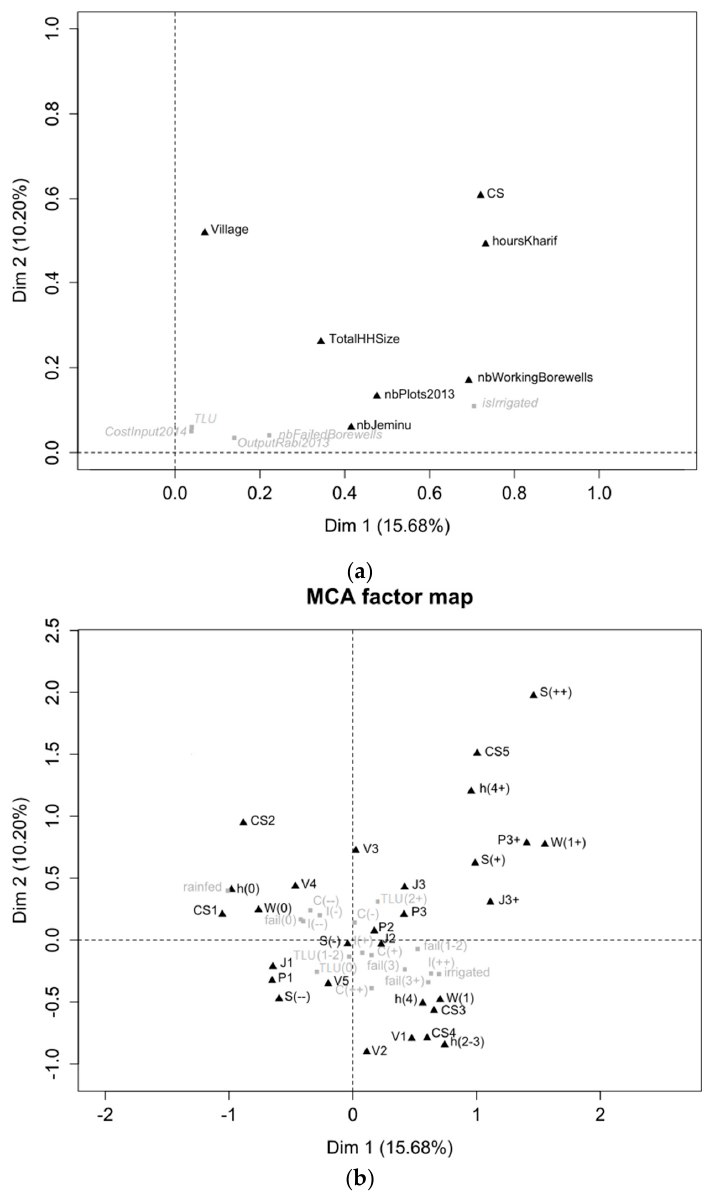
Figure 4. ( a ) Projection of the variables used to generate the farm typology in the plane of the first two factors of Multiple Correspondence Analysis (MCA); ( b ) Projection of the class of variables used to generate the farm typology in the plane of the first two factors of the MCA. Grey variables are complementary variables. Variables and classes are described in Table 1.